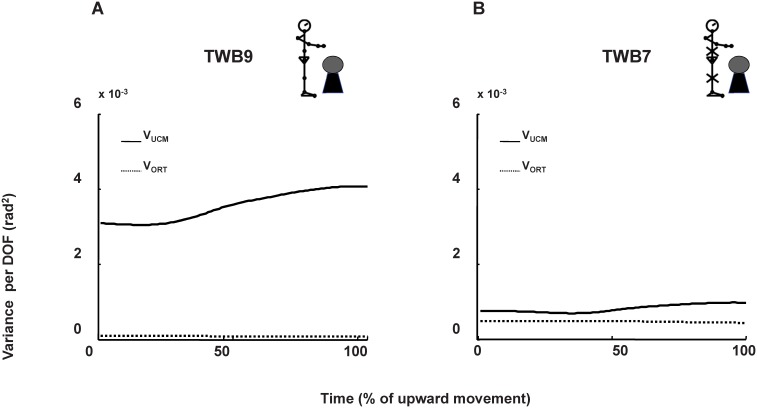
VUCM and VORT with respect to the COM control for a representative participant.A: Targeting combined with ball-balancing task in an unconstrained condition (TWB9). B: The same task with immobilized joints (TWB7). Solid lines represent the mean VUCMof all cycles and dashed lines represent the mean VORT of all cycles.